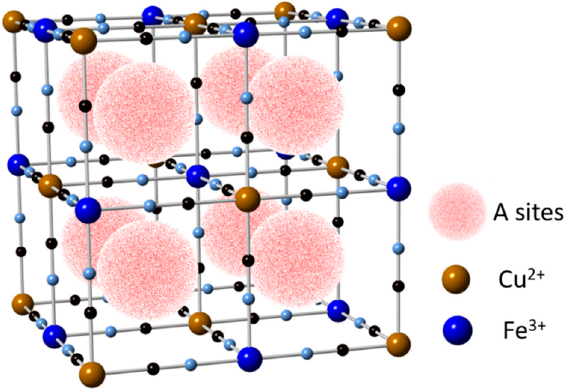
Figure 3. Crystal structure of Nickel Hexacyanoferrate (NiHCF) (ICSD no. 89338). Illustration based on [45,46].